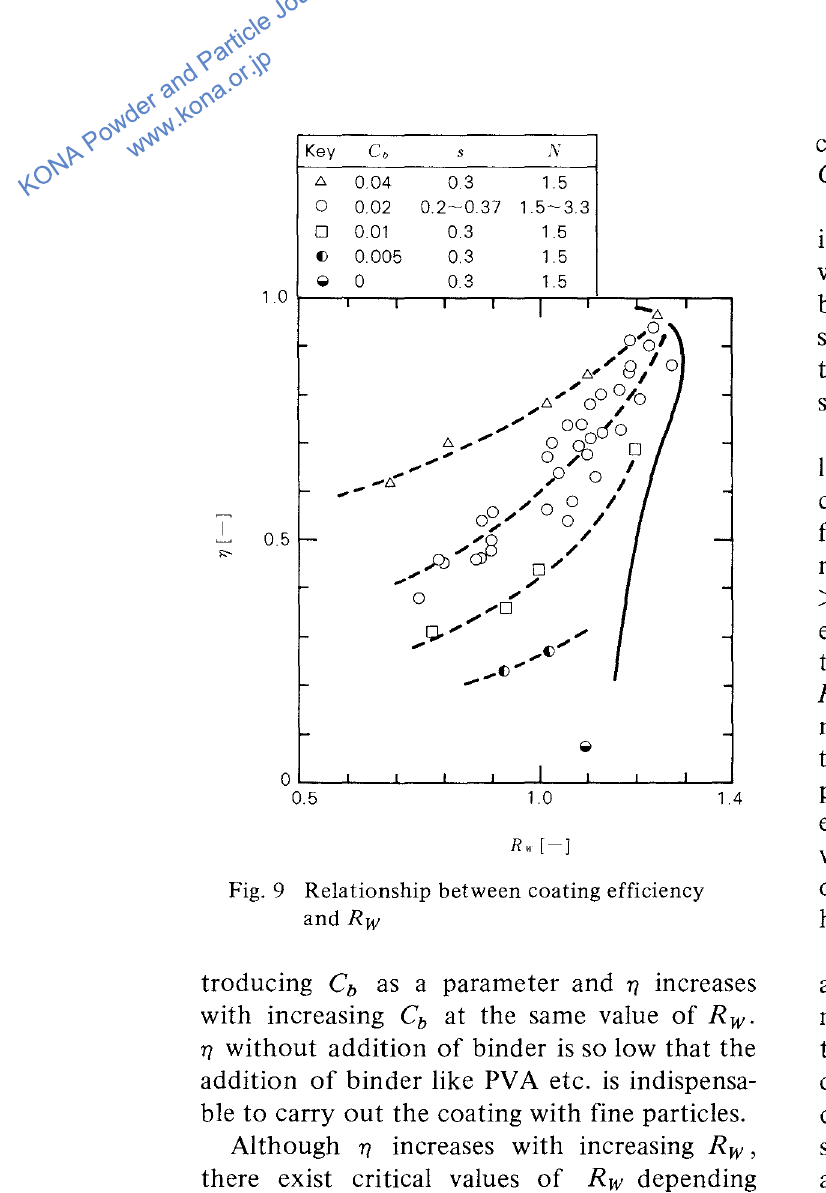
Fig. 9 Relationship between coating efficiency and